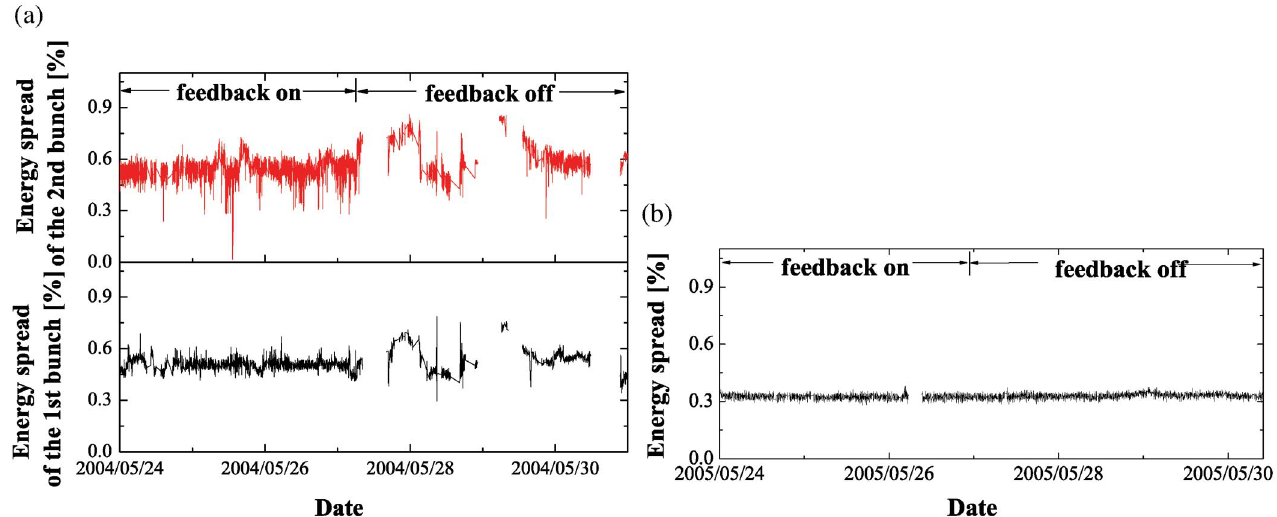
FIG. 7. (Color) Time traces of the energy spreads (a) for the first and second bunches of a high-current primary electron beam in the two-bunch acceleration mode, and (b) for the electron beam, measured at the 180 (cid:2) arc under the nominal operation condition with the feedback control on and off during seven days. 180 (cid:2) arc with the feedback control on and off during the same seven days. We could not find any large differences for the energy spread with the feedback control on and off. The energy spread was 0 : 33 (cid:1) 0 : 01 % during the KEKB